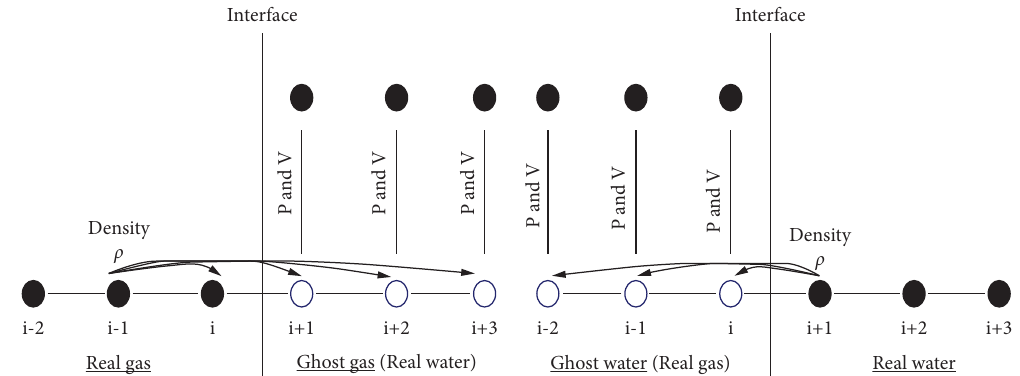
Figure 2: Extrapolation of density in 1D implementation of DGFM for explosive gas and water flow simulations [6].